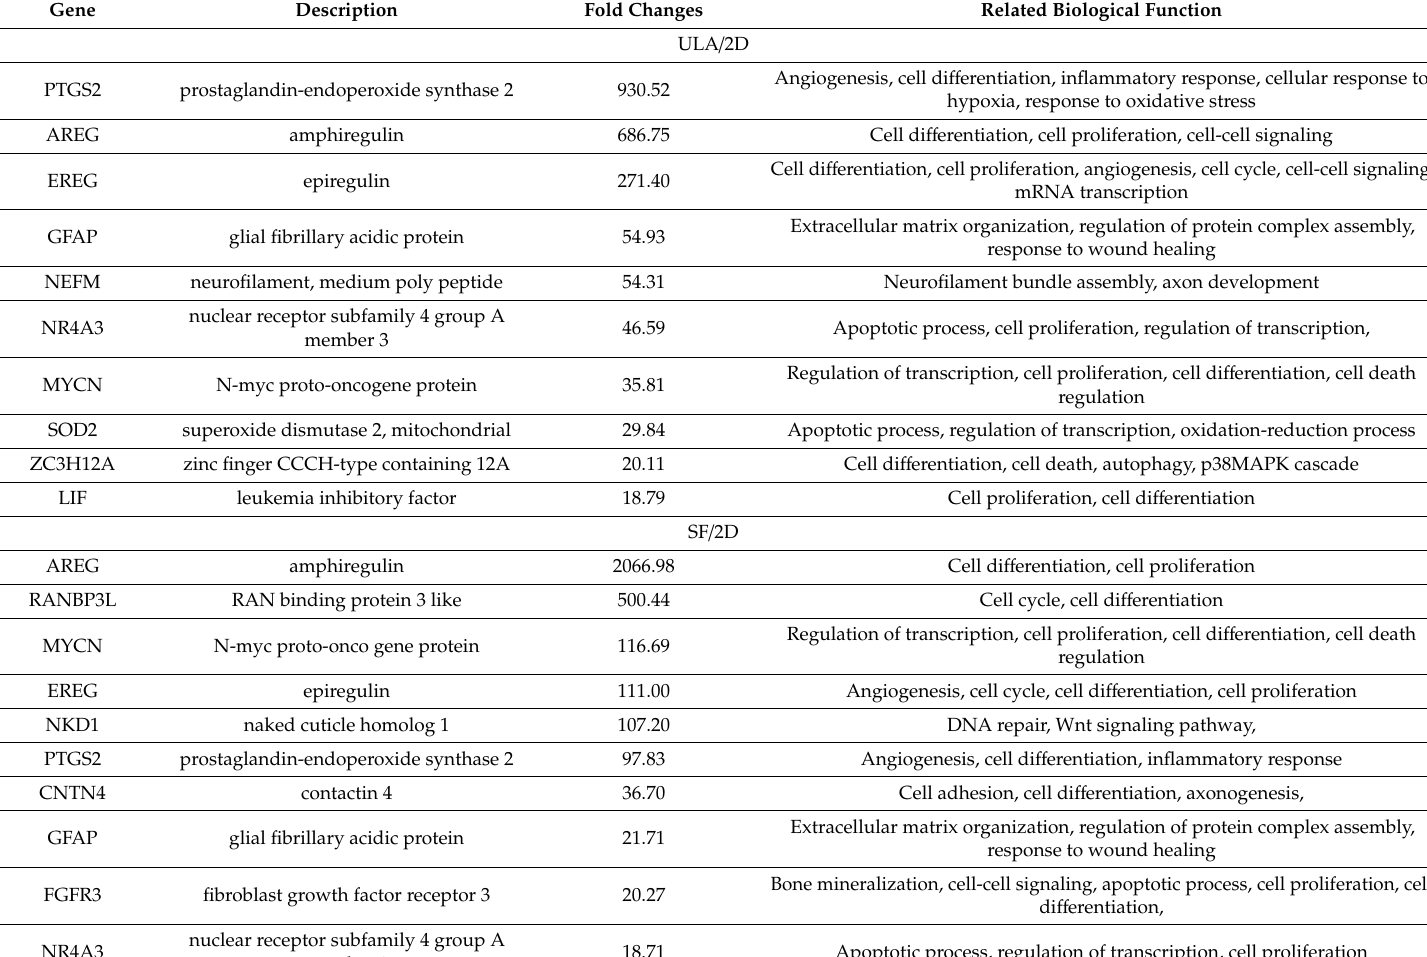
Table 3. List of the top 10 upregulated genes in expression by